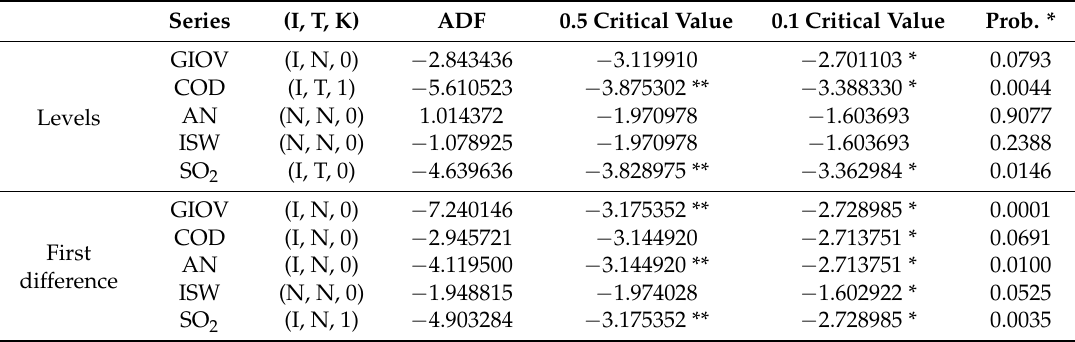
Table 2. Unit root test results for coal mining and washing.